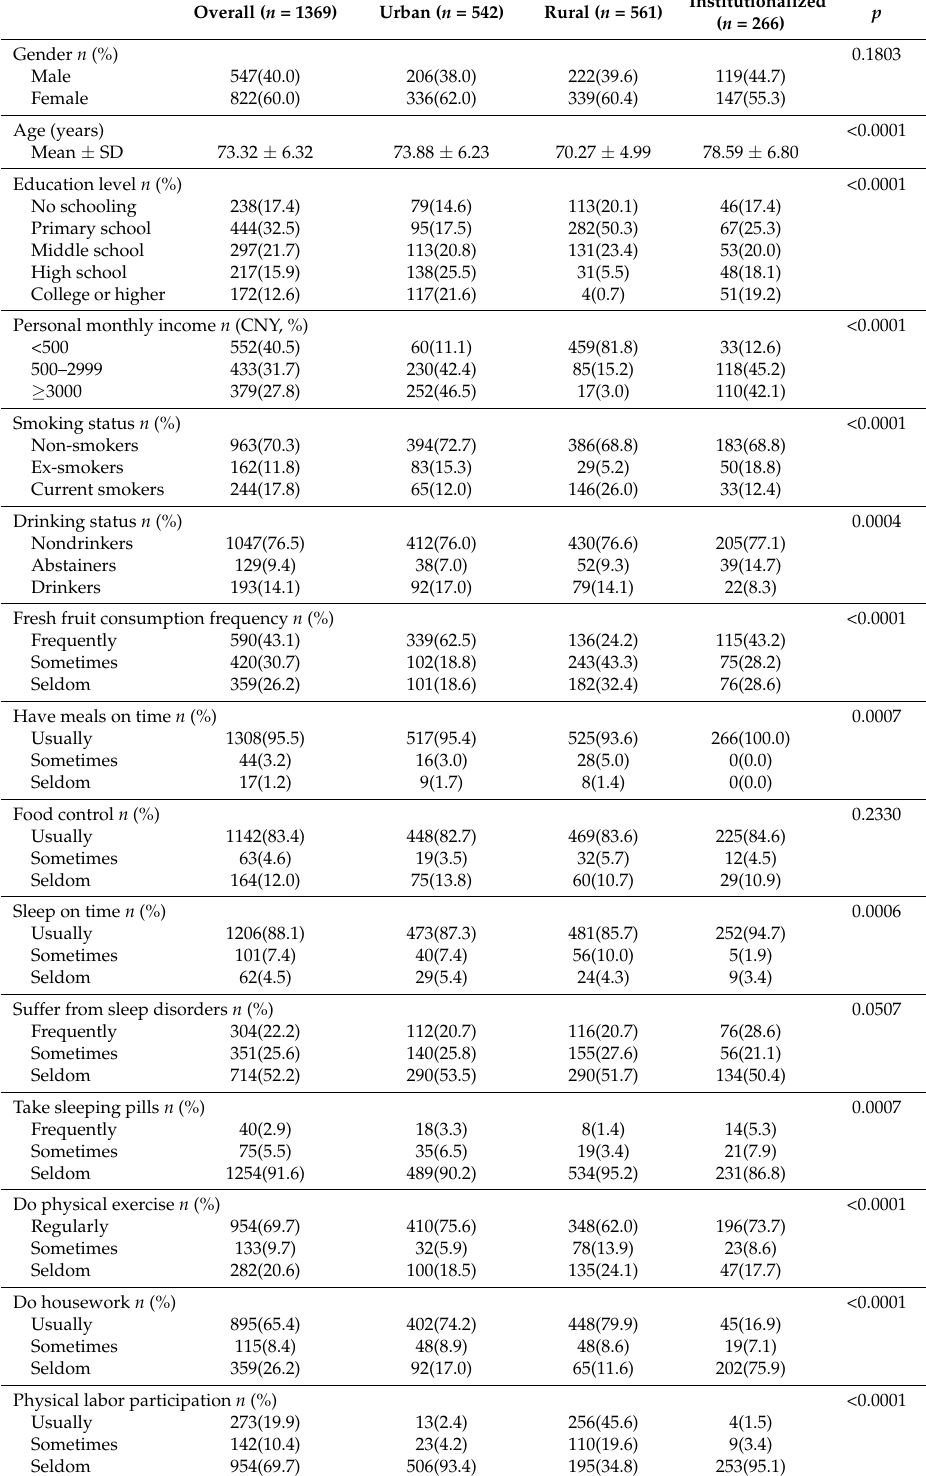
Table 1. Characteristics of participants and distributions of lifestyle factors #